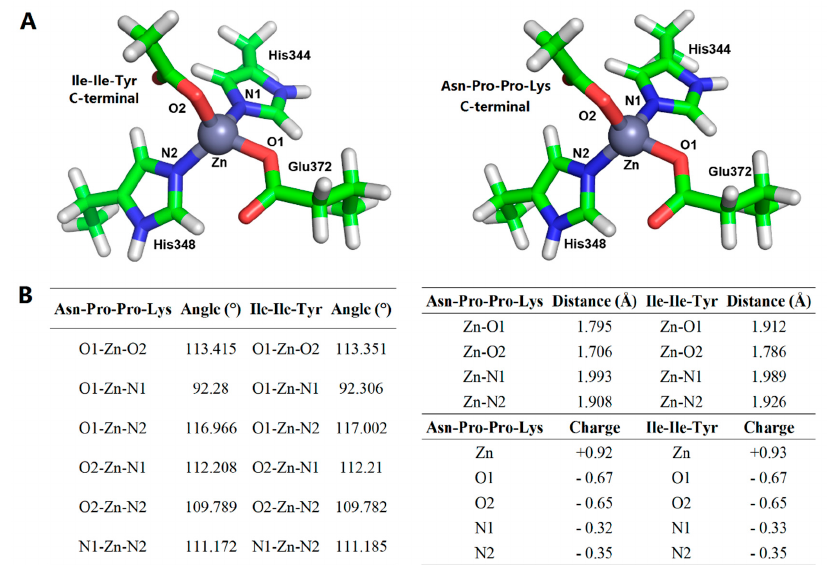
Figure 12. Coordination conformation ( A ) and related parameters ( B ) between ACE active center Zn(II) and inhibitory peptides (Ile-Ile-Tyr and Asn-Pro-Pro-Lys).